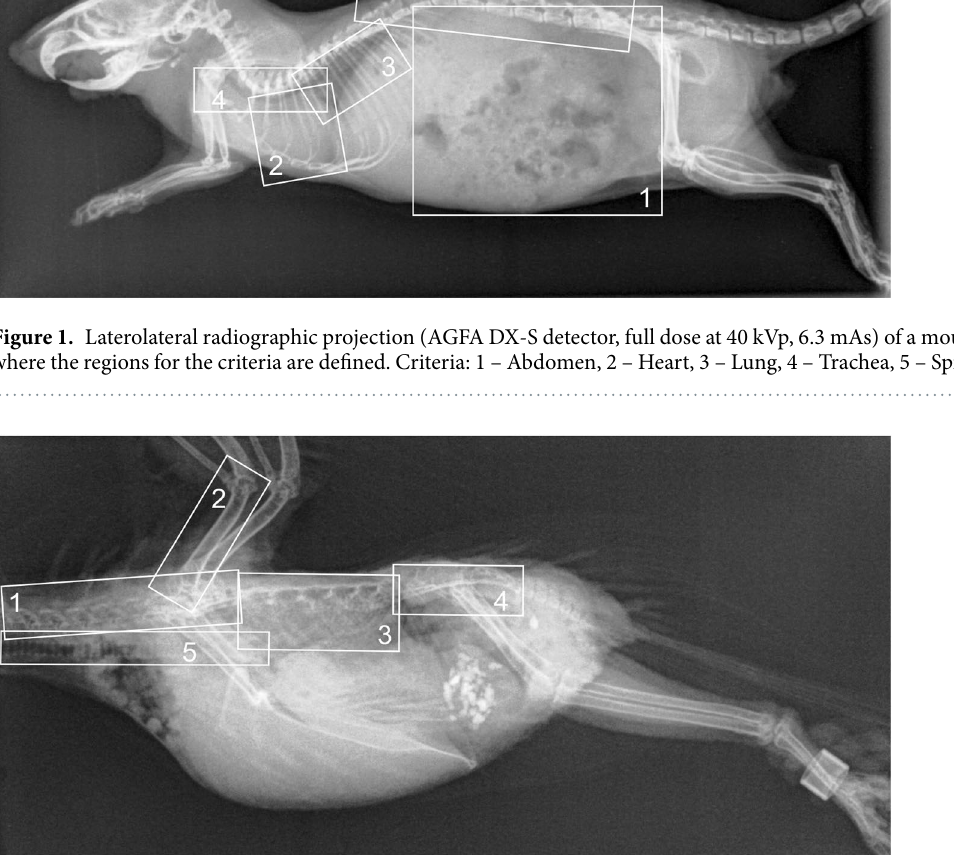
Figure 2. Laterolateral radiographic projection (AGFA DX-S detector, full dose at 40 kVp, 6.3 mAs) of a budgerigar where the regions for the criteria are defined. Criteria: 1 – Cervical spine, 2 – Humerus, 3 – Lung, 4 – Kidney, 5 – Tracheal